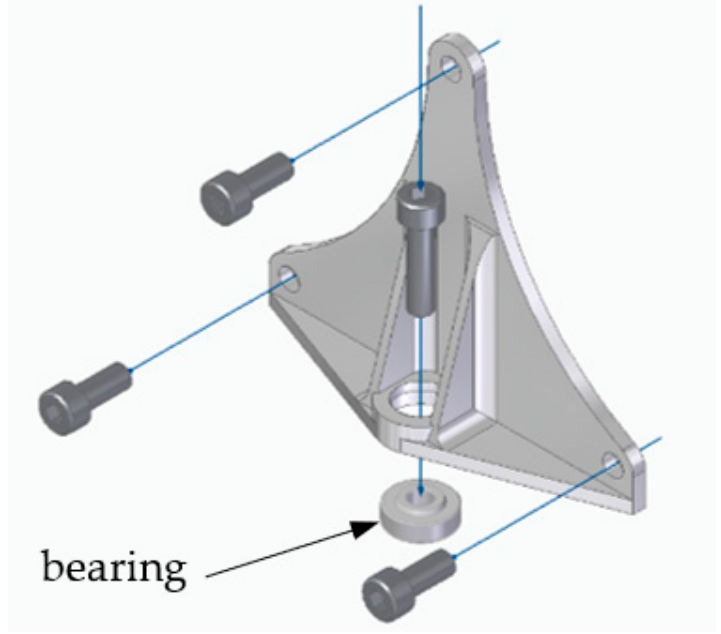
Figure 2. Wheel hub carrier bracket connections.